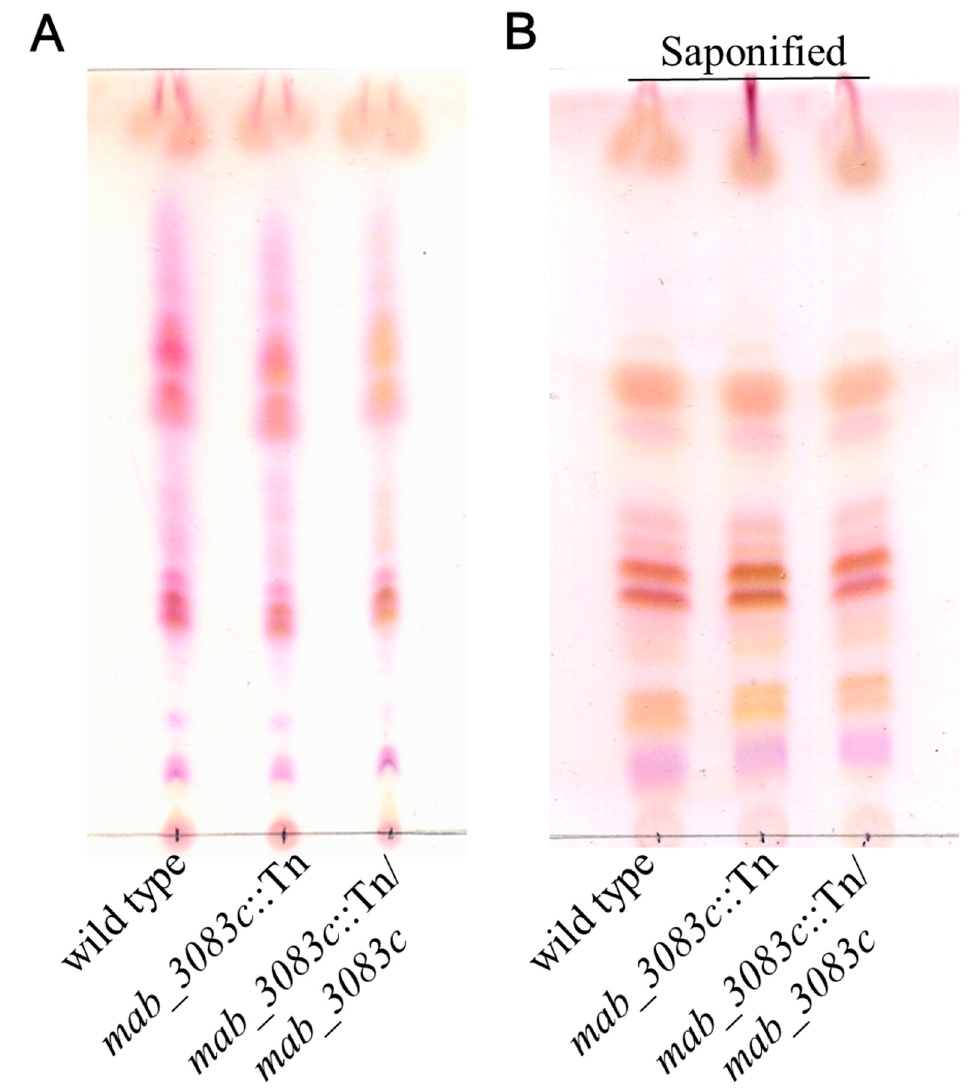
Figure 2. Comparison of glycopeptidolipid (GPL) production of wild type, mab_3083c::Tn, and complement strains of M. abscessus by Thin-Layer Chromatography (TLC). Total ( A ) and alkali stable (saponified) lipid ( B ) of wild type, mab_3083c ::Tn, and complemented ( mab_3083c ::Tn/ mab_3083c ) strains visualized with H 2 SO 4 .